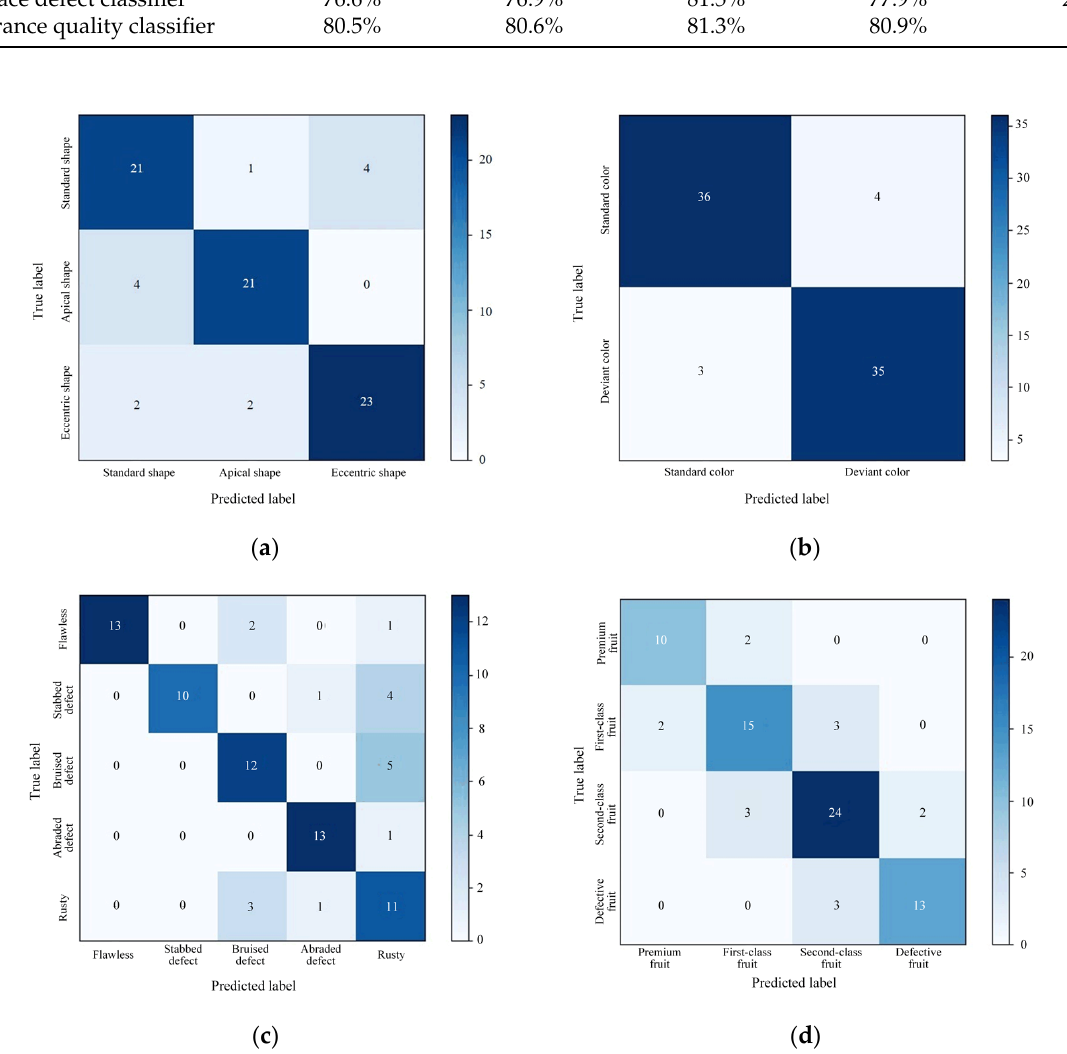
Figure 19. Confusion matrix for each classifier. ( a ) Classifier of pear shape. ( b ) Classifier of pear surface color. ( c ) Classifier of pear surface defect. ( d ) Classifier of pear appearance quality. Table 5. Classification performance of the four classifiers.